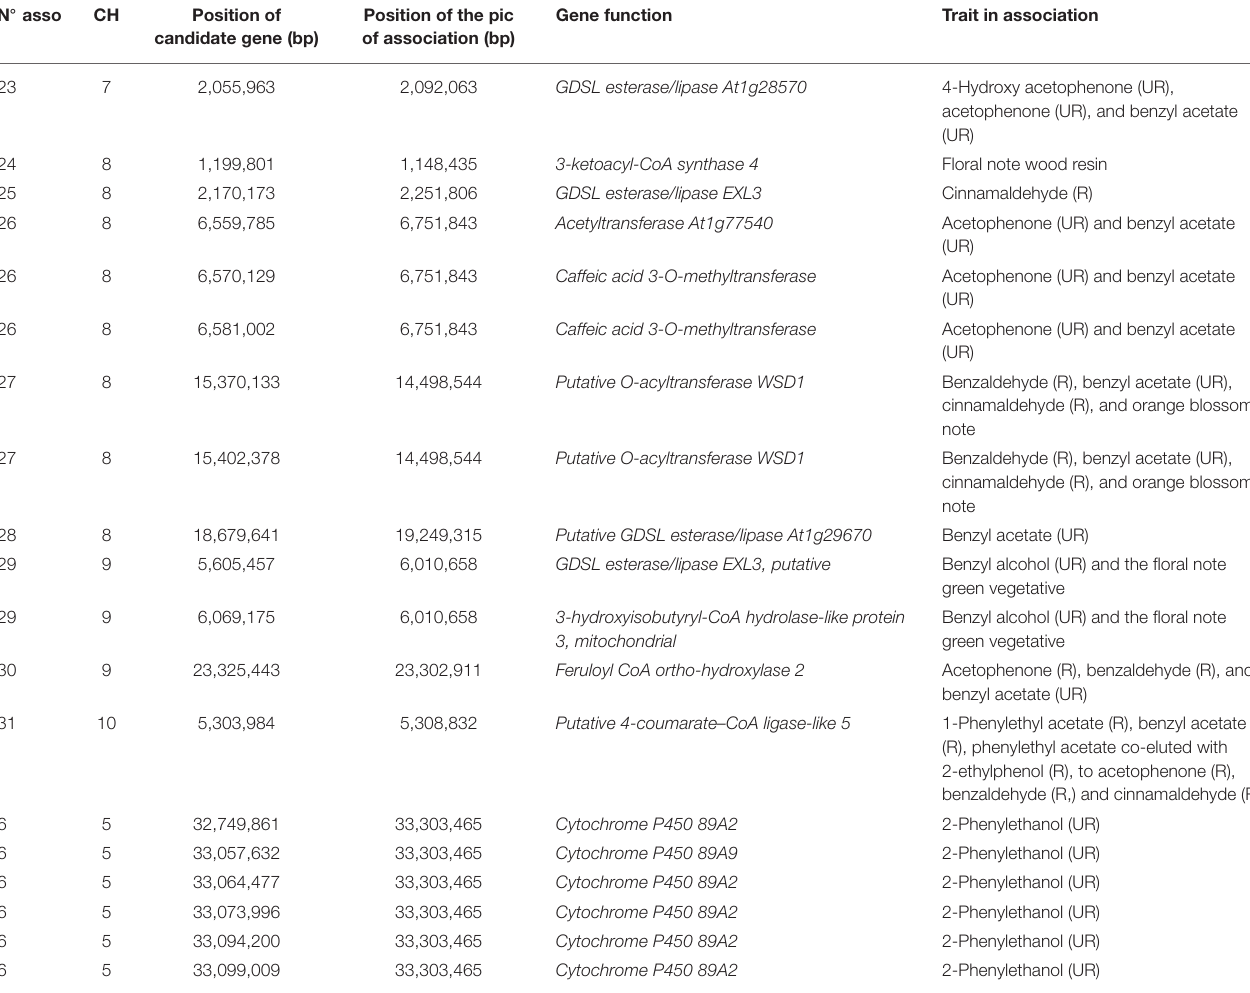
asso., Associations; CH, chromosome; R, Roasted beans; UR, unroasted beans. benzyl acetate (UR) contains a candidate gene encoding a “ GLOX Aldehyde oxidase .” An aldehyde oxidase is in some cases responsible for the oxidation of phenylacetaldehyde to phenylacetate, both of which are part of the L-phenylalanine degradation pathway (Kücükgöze and Leimkühler,